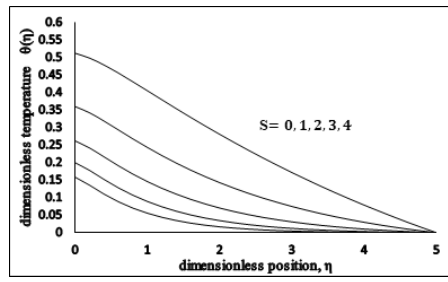
Figure 7. Dimensionless Temperature vs S .